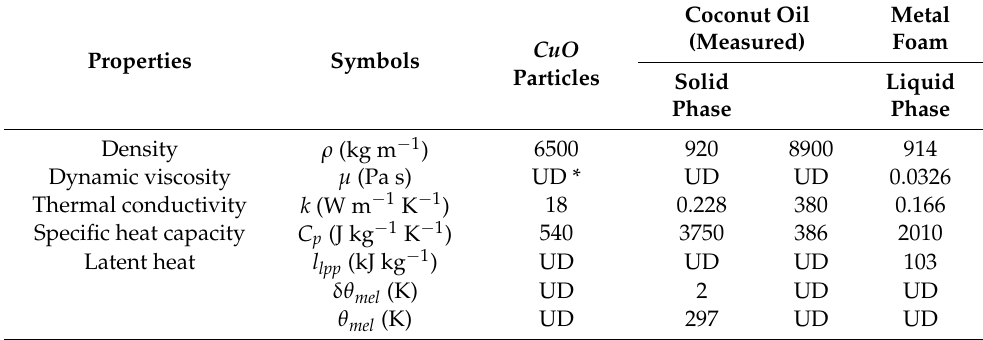
Figure 1. Latent heat thermal energy storage unit: ( a ) porosity with a positive gradient ( a > 0) and ( b ) porosity with a negative gradient ( a < 0). Table 1. Thermophysical properties of the coconut oil and nanoadditives